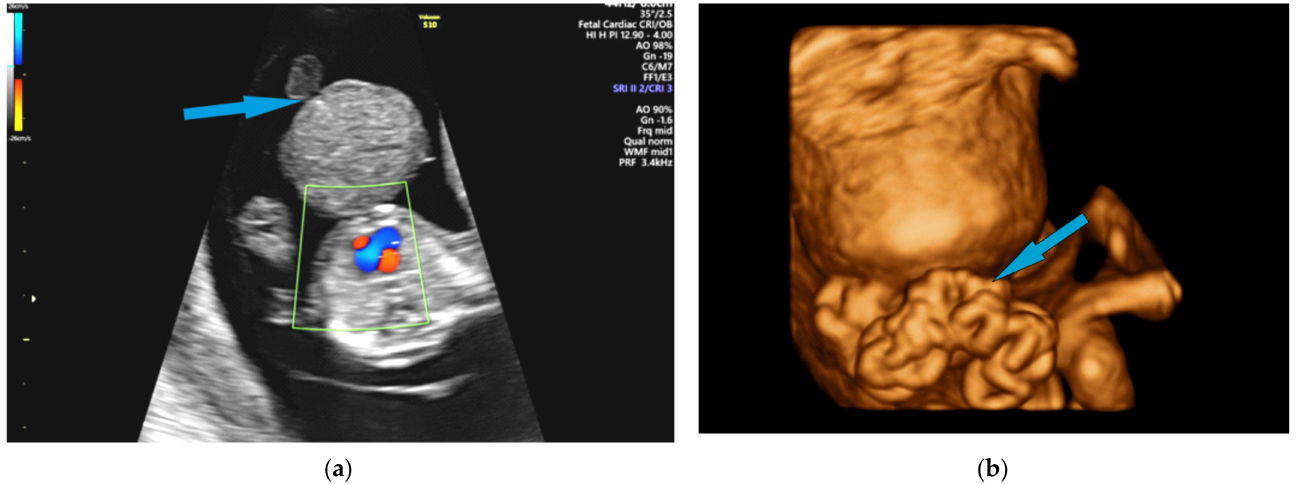
Figure 3. ( a , b ) Marginal insertion of the umbilical cord seen by color Doppler ultrasound.